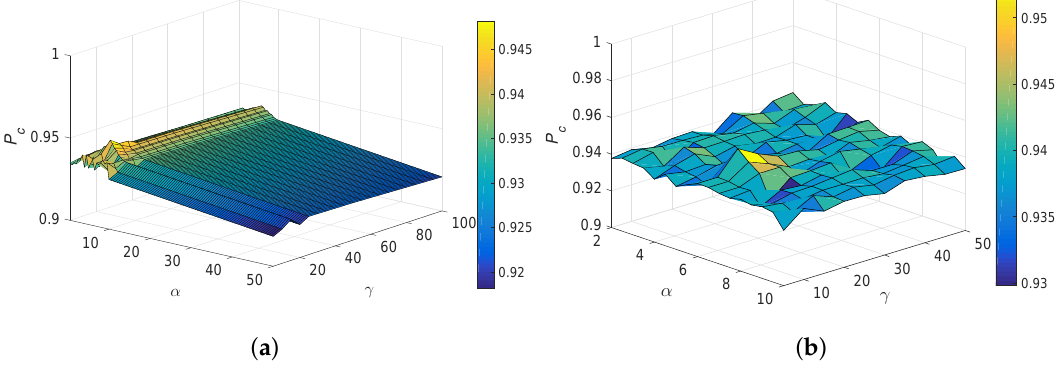
Figure 4. Model selection of the regularization parameters α and γ . ( a ) α ∈ [ 0.5,50 ] and γ ∈ [ 5,100 ] , ( b ) α ∈ [ 2,10 ] and γ ∈ [ 5,50 ]